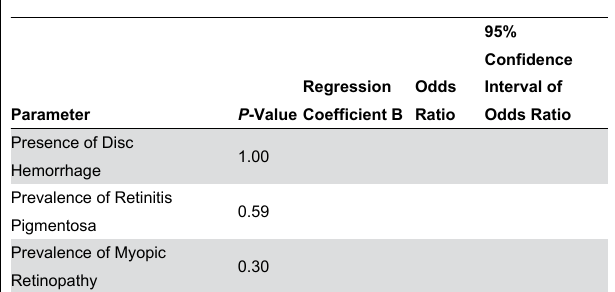
In a similar manner, the number of hours spent with vigorous outdoors activity was significantly associated with the prevalence of pterygia after adjustment for older age, male